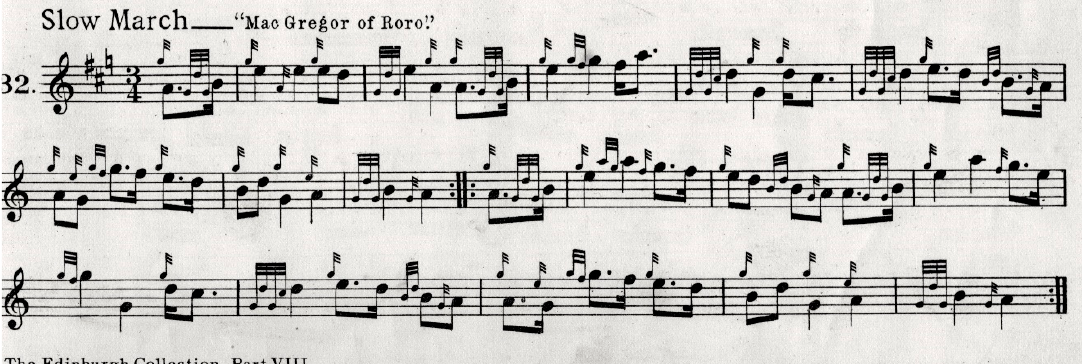
Figure 1. Pipe music by MacGregor of Roro.